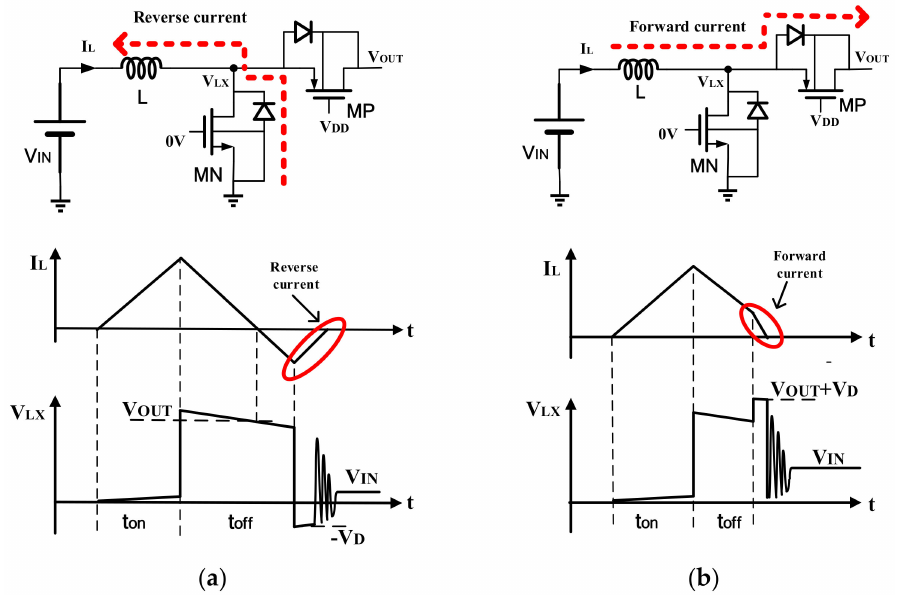
Figure 7. The discharge path of remaining current and waveforms after the MP is turned off ( a ) slowly and ( b ) quickly.